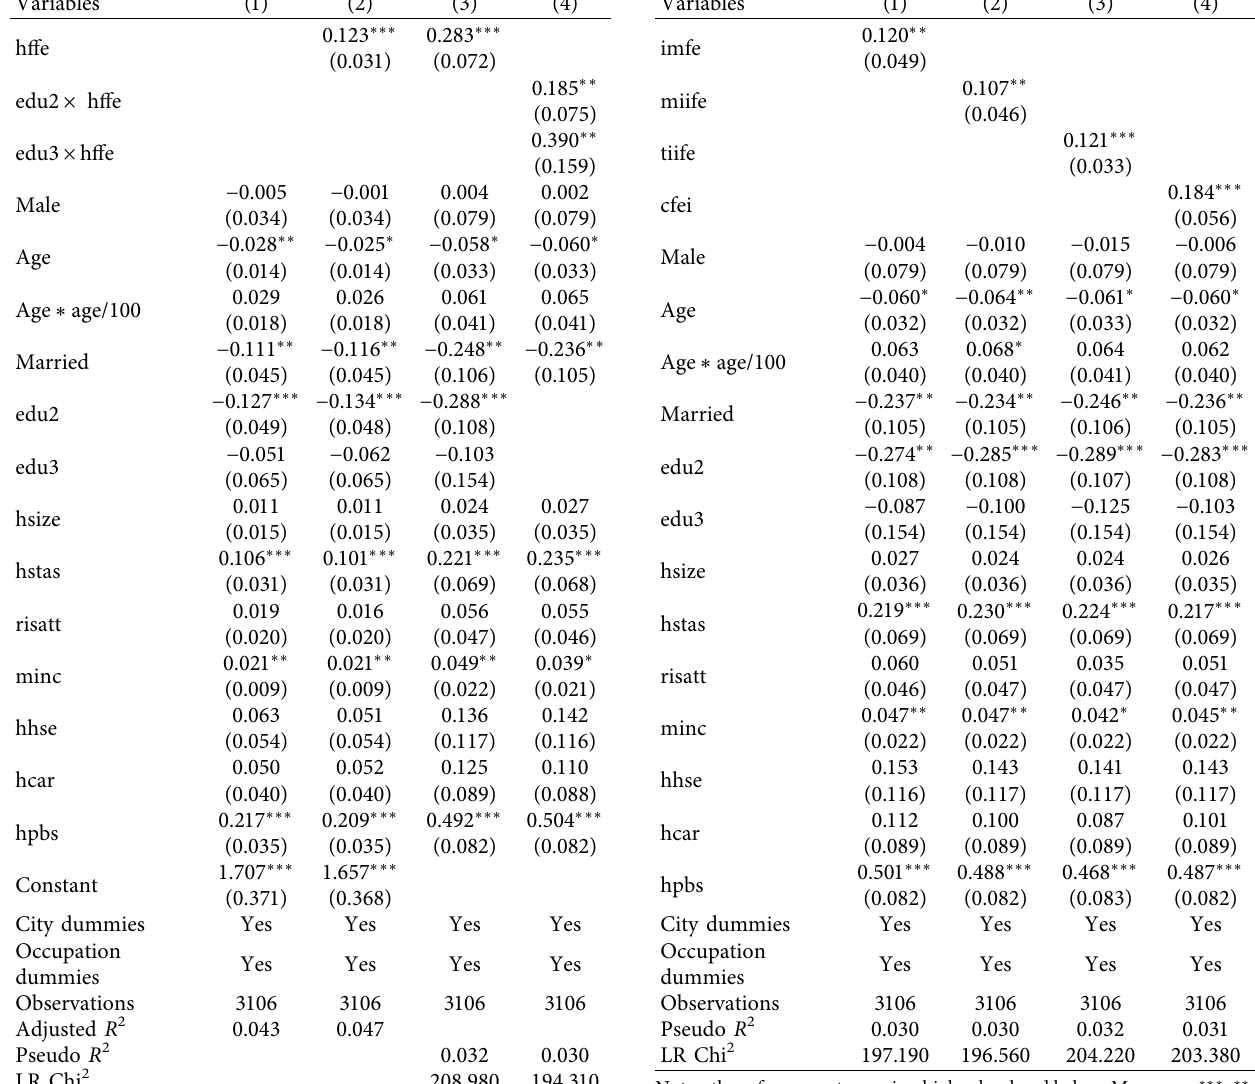
Table 5: Results of regressions of having received formal fnancial education on consumer stock market satisfaction.